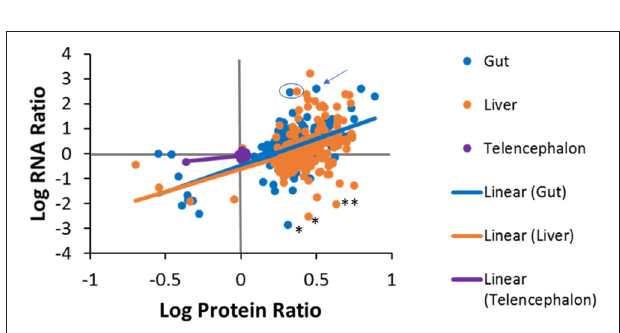
FIGURE 7 | Tissue specific correlations between protein log ratios and RNA log ratios for genes that were identified in both experiments. Solid lines are tissue-specific regression lines. Examples discussed in the manuscript text are denoted with the following symbols; * fatty acid binding protein 7 (fabp7), ** (gapdh), the arrow points to dipeptidase 1 (dpep1) and the blue circle encloses carboxypeptidase A1 (cpa1) in the liver and the